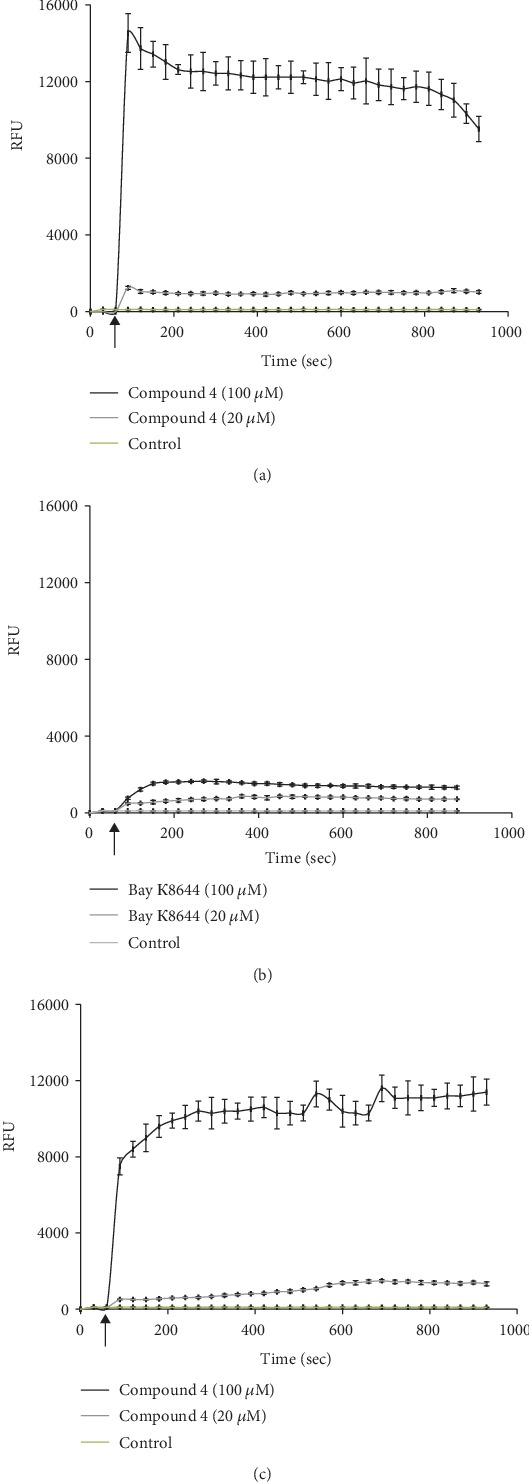
The dose-dependent calcium ion channel agonist activity. (a) [Ca2+]i responses to different concentrations of agonist compound 4 in SH-SY5Y cells. (b) [Ca2+]i responses to different concentrations of agonist Вау K8644 in SH-SY5Y cells. (c) [Ca2+]i responses to different concentrations of agonist compound 4 in A7R5 cells. The cells were stimulated by the addition of compound 4 or Bay K8644 in concentration range from 20 to 100 μM. Control is Fura-4 NW loaded cells without stimulator. Arrow indicates the time of compound 4 and Bay K8644 addition. Values were presented in RFU (relative fluorescence units) ± SD.